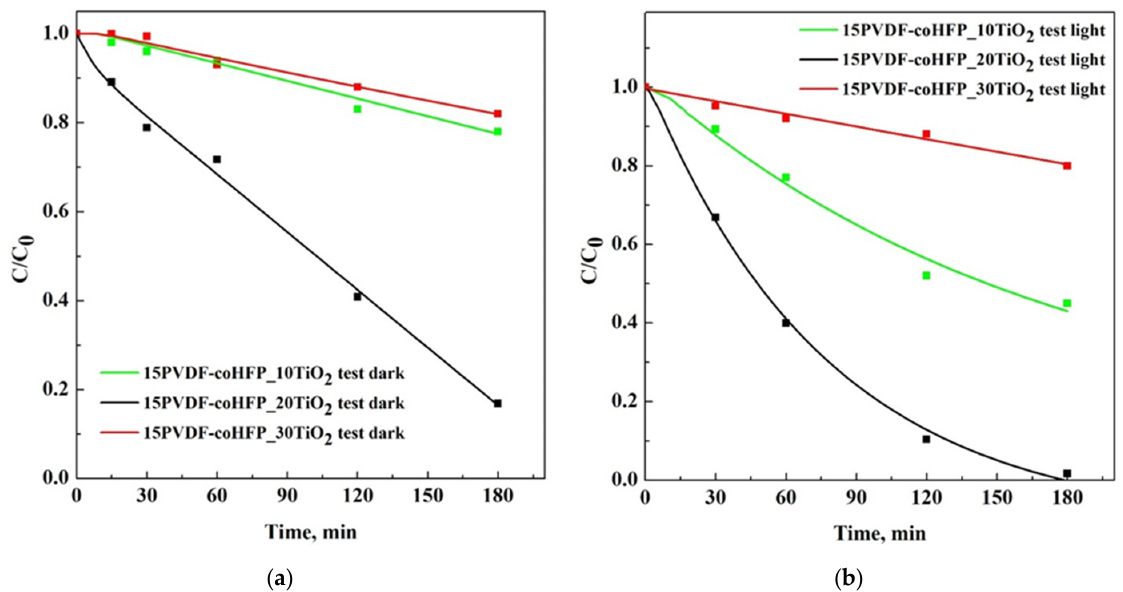
Figure 7. Comparison among 15PVDF-coHFP_10TiO 2 , 15PVDF-coHFP_20TiO 2 , and 15PVDF-coHFP_30TiO 2 for the degradation of SB in dark conditions ( a ) and under the exposure to UV light ( b ).